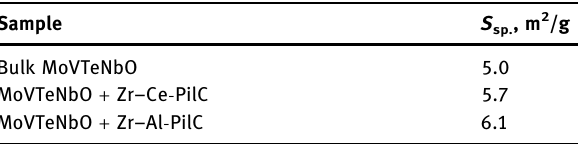
Table 3: Speci fi c surface area of catalysts Sample